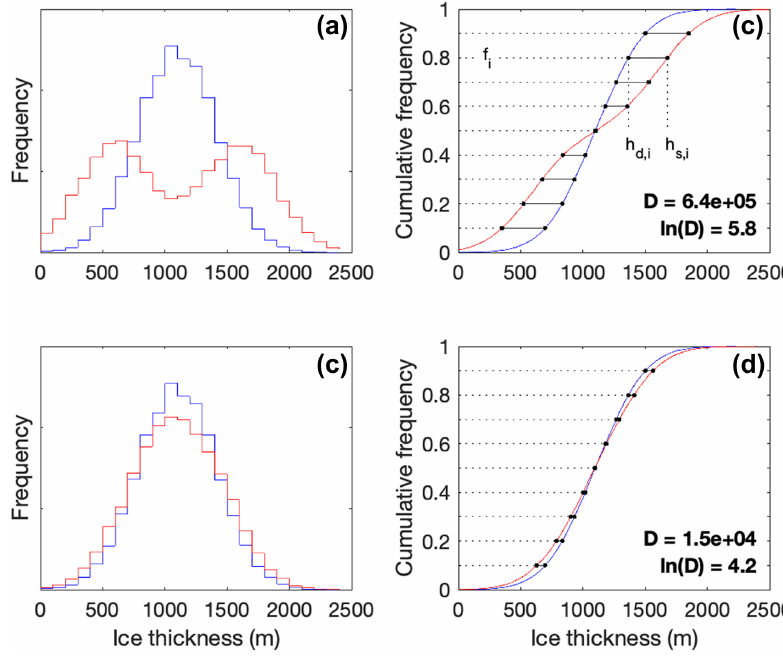
Figure 5. Method of quantifying difference between model ice thickness CDFs. Panels (a) and (b) represent a hypothetical site with large differences between sensitized and desensitized models, and panels (c) and (d) represent a hypothetical site with similar ice thickness behaviour between models. Red and blue curves are the hypothetical output from desensitized (blue) and sensitized (red) ice sheet model runs, displayed as histograms (a, c) and CDFs (b, d) . The difference between two CDFs is quantified by sampling the difference between the elevations of the two CDFs at evenly spaced values of cumulative frequency (the black line segments in right panels) and computing a total CDF difference metric D (see text) as the sum of squares of the individual differences. As D ranges over several orders of magnitude, for convenience we plot ln( D ) in subsequent figures.